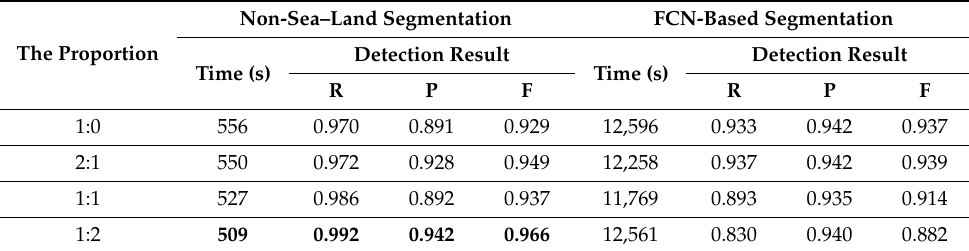
Table 6. Results and time spent of detection of the first GF-2